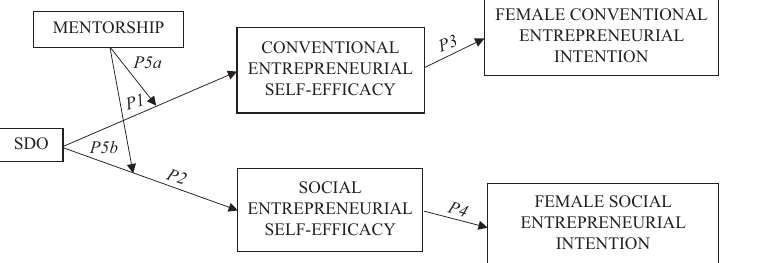
Figure 1. Relationships of propositions (P) in theoretical